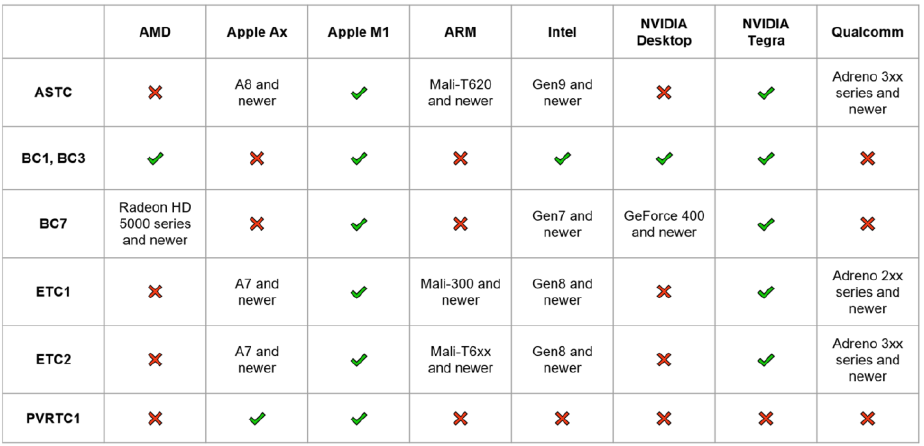
Table 3. GPU Compressed Texture Format Fragmentation. Multiple GPU Compressed Texture formats with varying levels of support across diverse platforms. (Khronos Group, 2021).